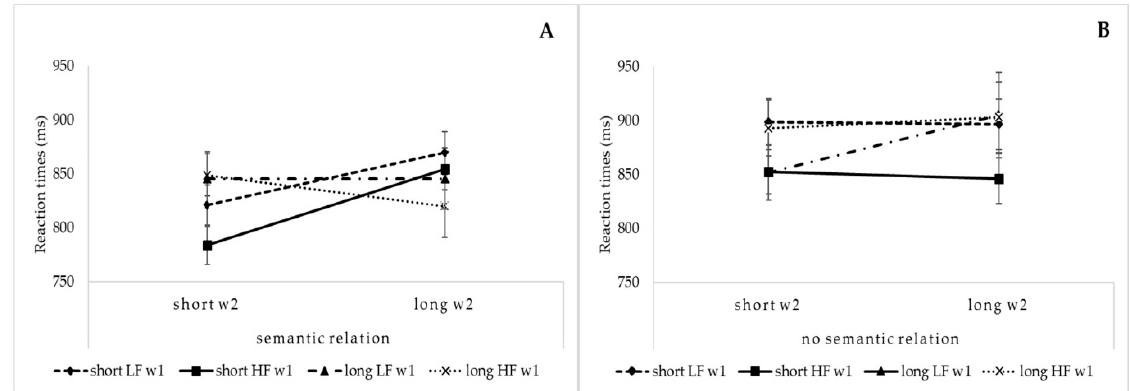
Figure 3. Mean vocal reaction times (ms) when w1 is short and long (Panel A = semantically related; Panel B = semantically unrelated). LF = low-frequency; HF = high-frequency.